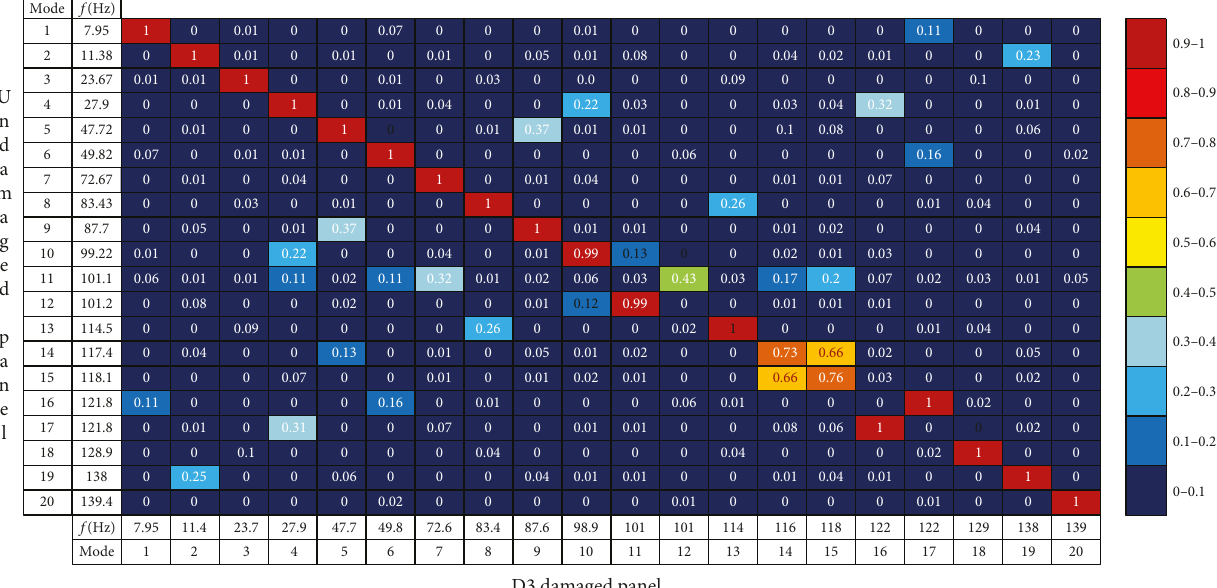
Figure 15: Undamaged panel – D3 damaged panel